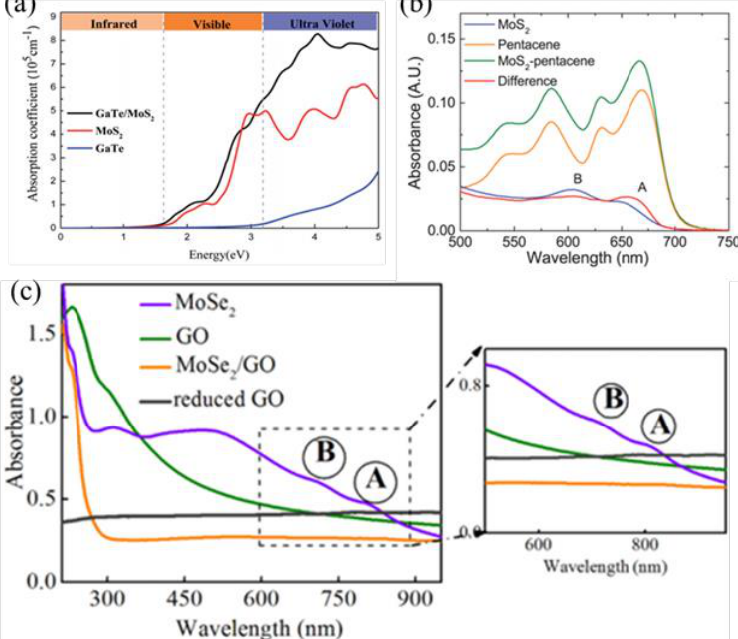
Figure 5. ( a ) Adsorption coefficients of the GaTe monolayer, MoS 2 monolayer, and GaTe/MoS